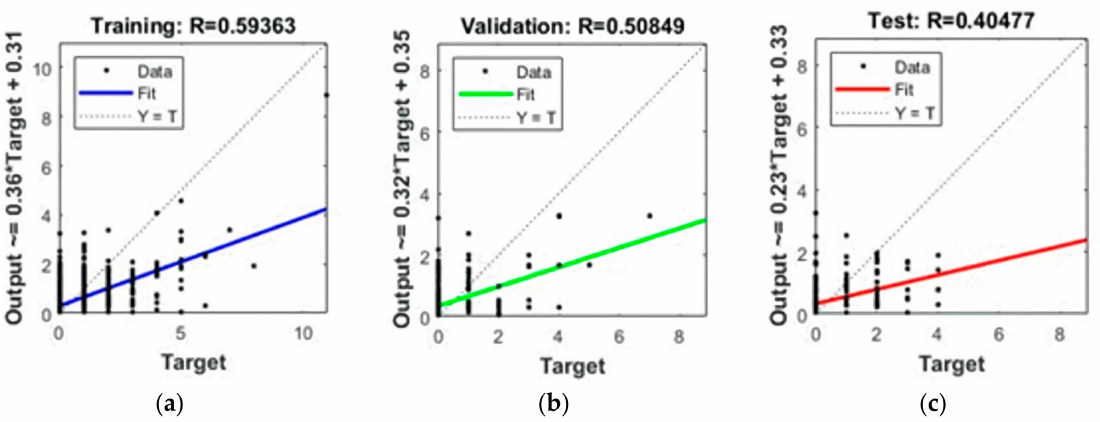
Figure 9. Cluster C model for crime occurrence prediction (layer: 2, node: 7); ( a ) Training data regression result; ( b ) Validation data regression; ( c ) Test data regression result.